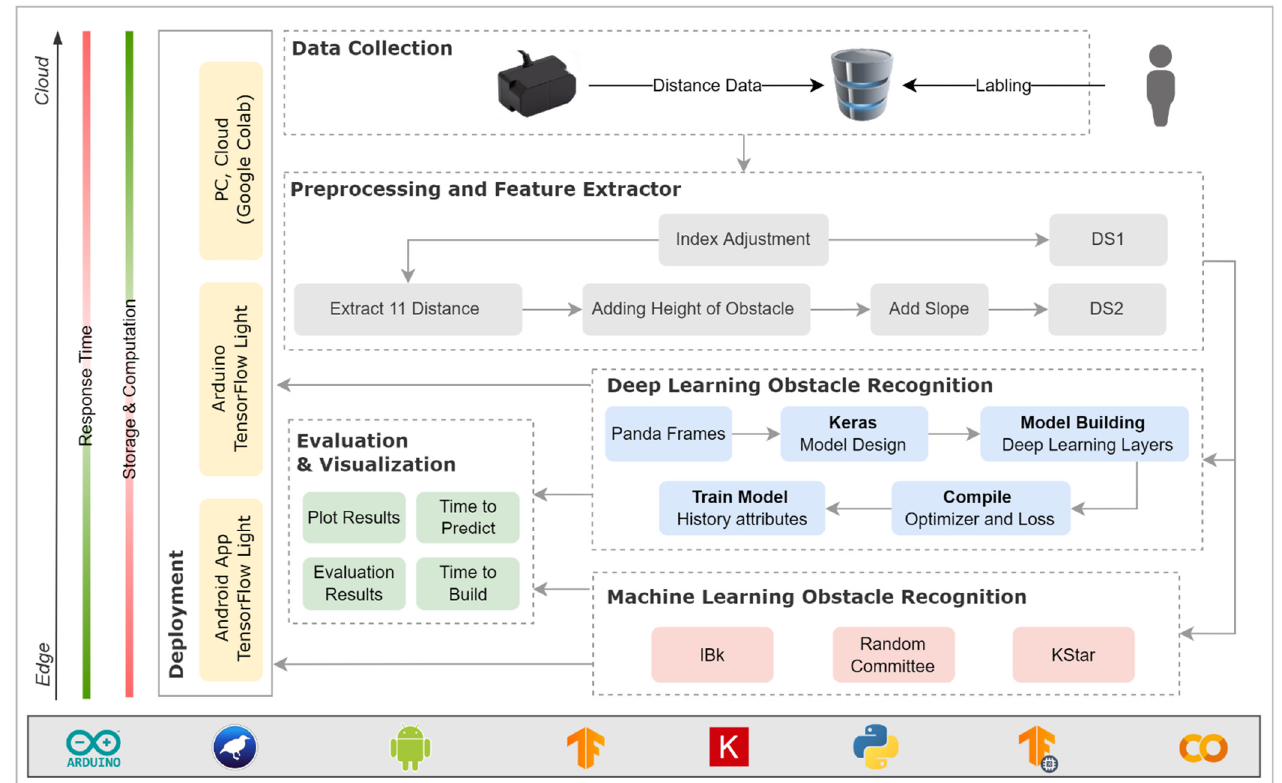
Figure 14. Machine and Deep Learning Modules.